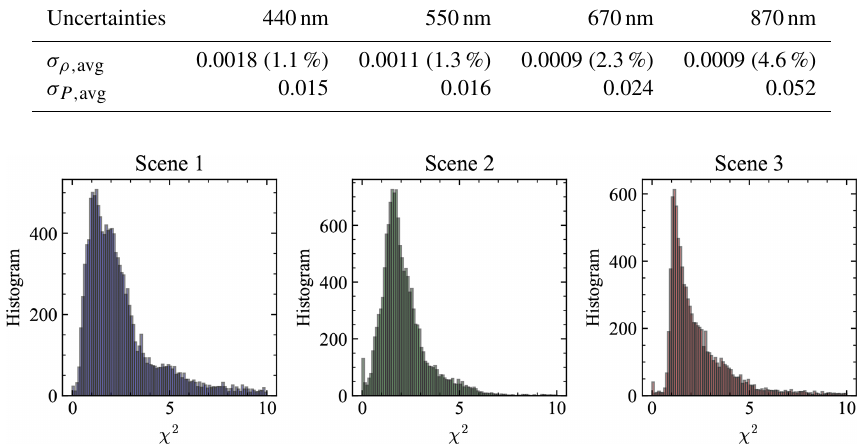
Figure 14. The histograms of the cost function values over the three scenes as shown in Fig. 12 with total pixel numbers of 13491, 13226, and 9159. Only pixels over ocean are